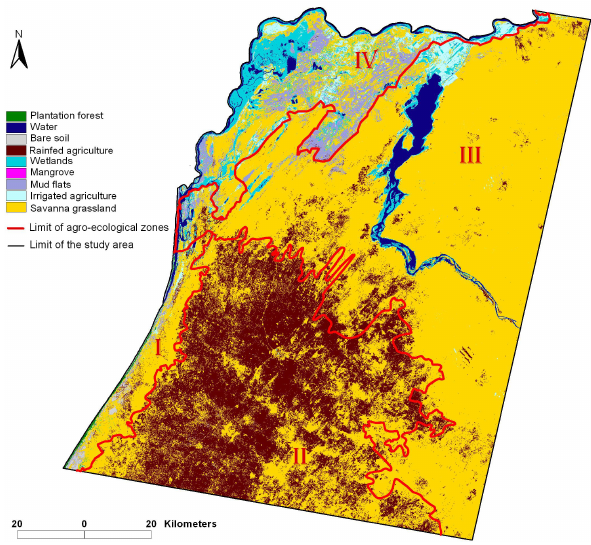
Fig. 1. Landsat 28.5m hard decision tree classification of the study area in north-western Senegal, covering 1560km 2 lying 15 ◦ 24 0 – 17 ◦ 00 0 W and 15 ◦ 00 0 –16 ◦ 42 0 N. Dry and wet season 2002 Landsat data were classified using a bagged decision tree classification pro- cedure into 9 land cover land use classes (plantation forest, water, bare soil, rainfed agriculture, wetlands, mangrove, mud flats, irri- gated agriculture, and savanna grassland). The study area is shown bounded by a black vector. White shows unclassified (clouds, cloud shadows, settlement areas, or no Landsat data). The boundaries of the four main agro-ecological zones (I: Niayes; II: Peanut Basin; III: Sandy Ferlo; and IV: Senegal River Valley) are shown as red